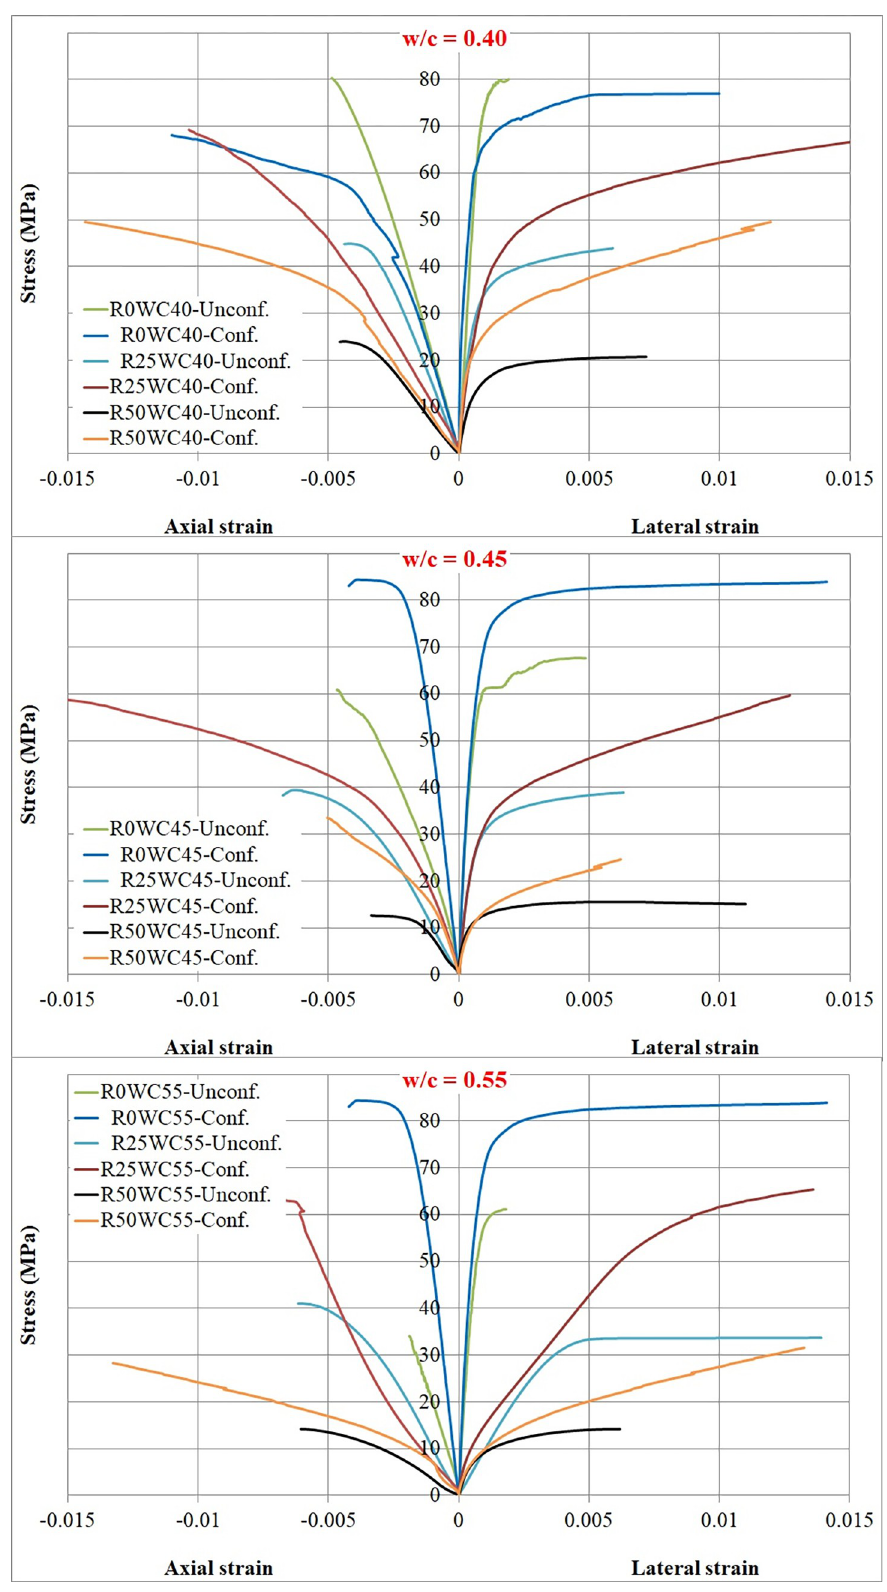
Fig 6. Stress-strain curves of confined and unconfined specimens with different w/c. https://doi.org/10.1371/journal.pone.0269664.g006 PLOS ONE | https://doi.org/10.1371/journal.pone.0269664 July 13,